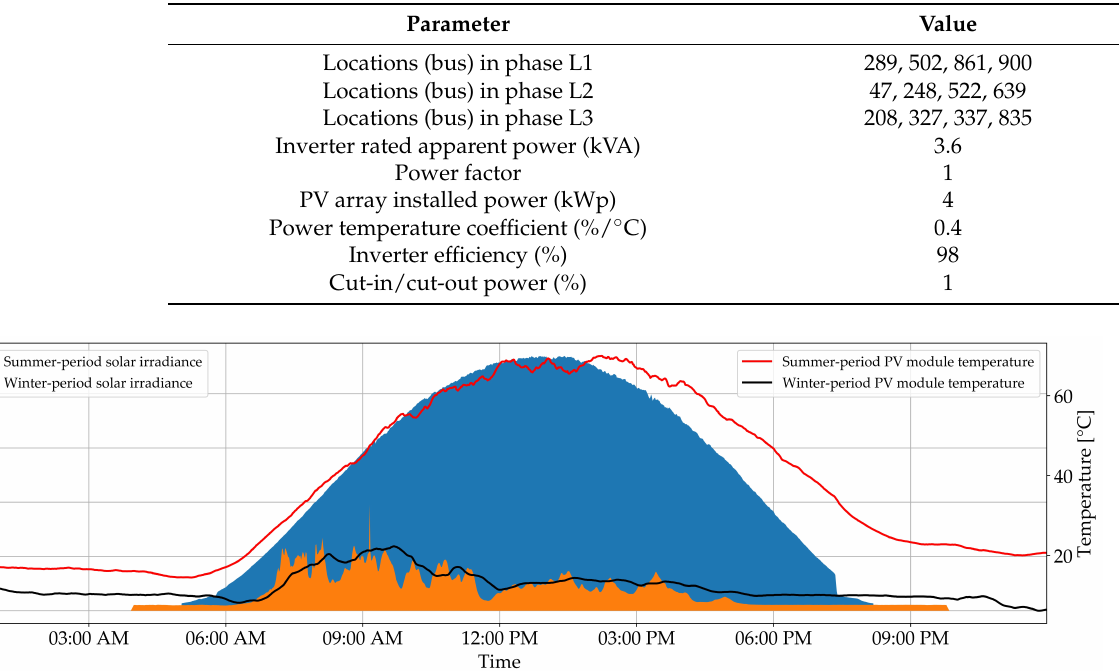
Table 7. Technical characteristics and locations of PV systems in the distribution network.